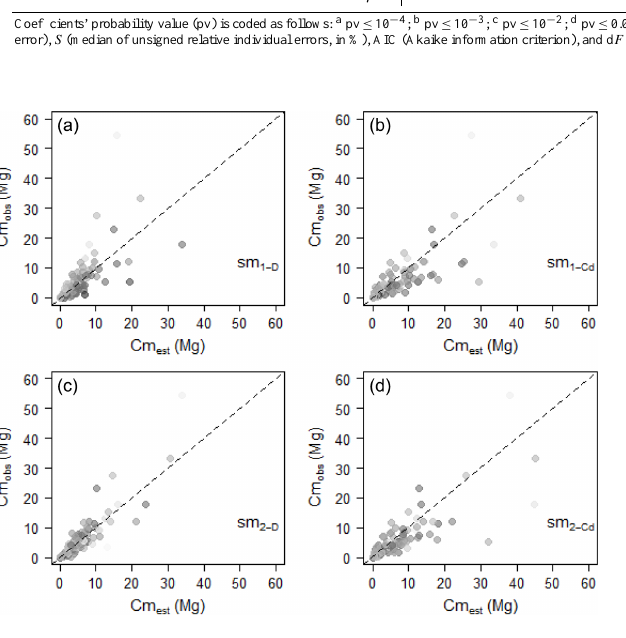
Figure A2. Observed vs. estimated crown mass (in Mg) for models sm 1-D (a) , sm 1-Cd (b) , sm 2-D (c) , sm 2-Cd (d) . Models were cal- ibrated on Data CD . Tree wood density was standardized to range between 0 and 1 and is represented as a greyscale (with black the lowest values and white the highest